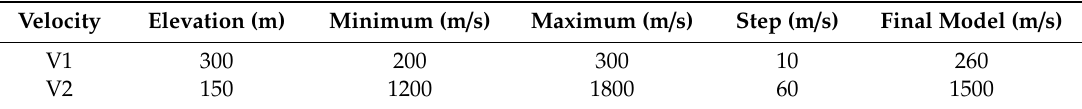
Table 1. Range of values of the upper (V1) and lower (V2) velocities in the experimental